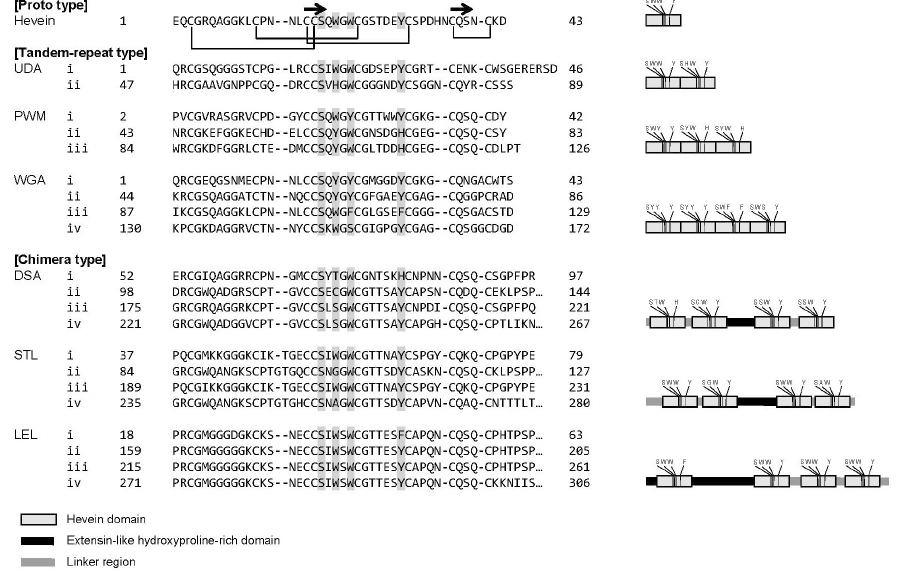
Figure 1. Alignment of amino-acid sequences of the six chitin-binding lectins investigated in this work. Hevein, constituting a sole proto-type lectin, is shown as a reference. The sequences are of UDA6 isolectin (GenBank/EMBL/DDBJ accession number AAD05433) for UDA, PLC isolectin (AB052963) for PWM, WGA1 isolectin (UniProtKB accession number, P10968) for WGA (categorized as tandem-repeat type), LEL (AB360604), DSA-B isolectins (AB618634) for DSA, and STL (Q9S8M0; categorized as chimera type). Bold arrows on the top denote the regions of β -strands. Schematic representations are made for each lectin on the right, where four amino-acid residues essential for chito-oligosaccharide-binding in hevein, i.e., Ser (S), two Trp (W), and Tyr (Y) are shown in each hevein domain shown with a gray box. The extensin-like, function-unknown domain is shown with a black bar.